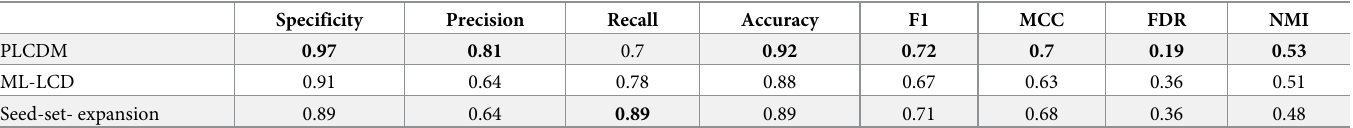
Table 3. Evaluating PLCDM the Multilayer1 data.